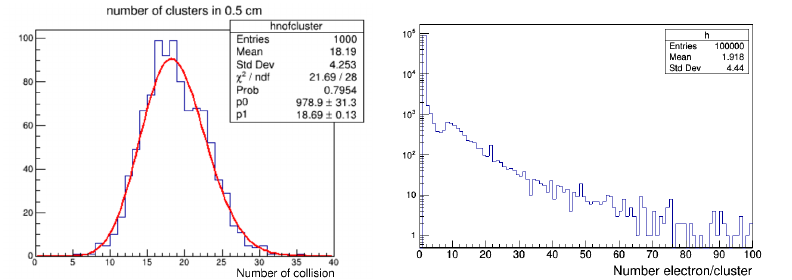
Figure 1: Left: distribution of the number of primary electrons ( i.e. clusters) generated in the ionization created by 150 GeV / c muons in 5 mm Ar + 10% iC 4 H 10 ; the histogram is fitted with a Poissonian distribution. Right: distribution of the number of electrons per cluster; the histogram is tabulated to be implemented in the simulation.